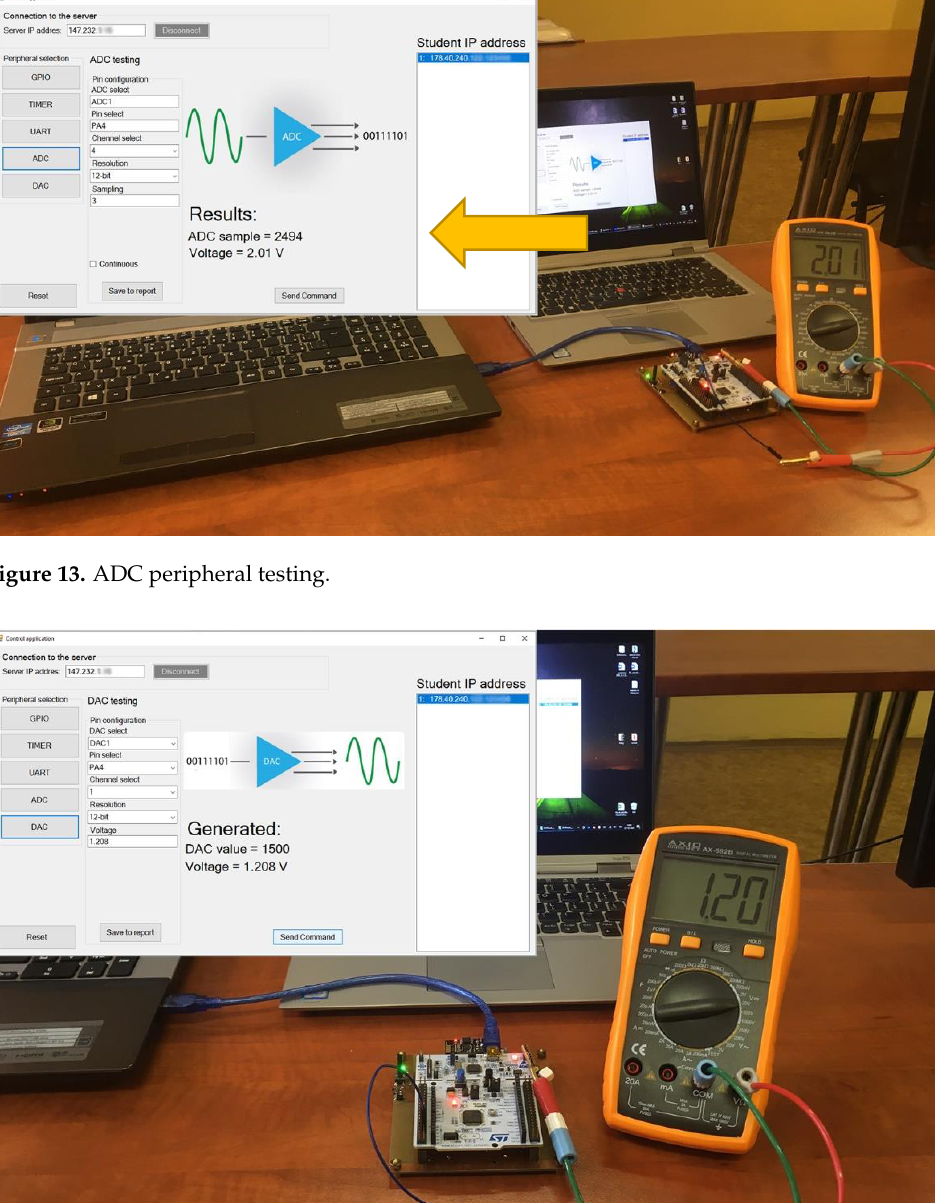
16 of 23 Figure 12. UART peripheral testing. Communication took place on baud rate 115200 without parity bit and one STOP bit. The UART peripheral test is possible only via USART1 shared on the PA9 and PA10 pins. The teacher can thus send any command to the student microcontroller, on which the microcontroller will perform the required operations. The following test was performed on the ADC peripheral. In this case, the IoT mon- itoring device was set to ADC mode. ADC1 and channel 4 were selected on the PA4 pin.